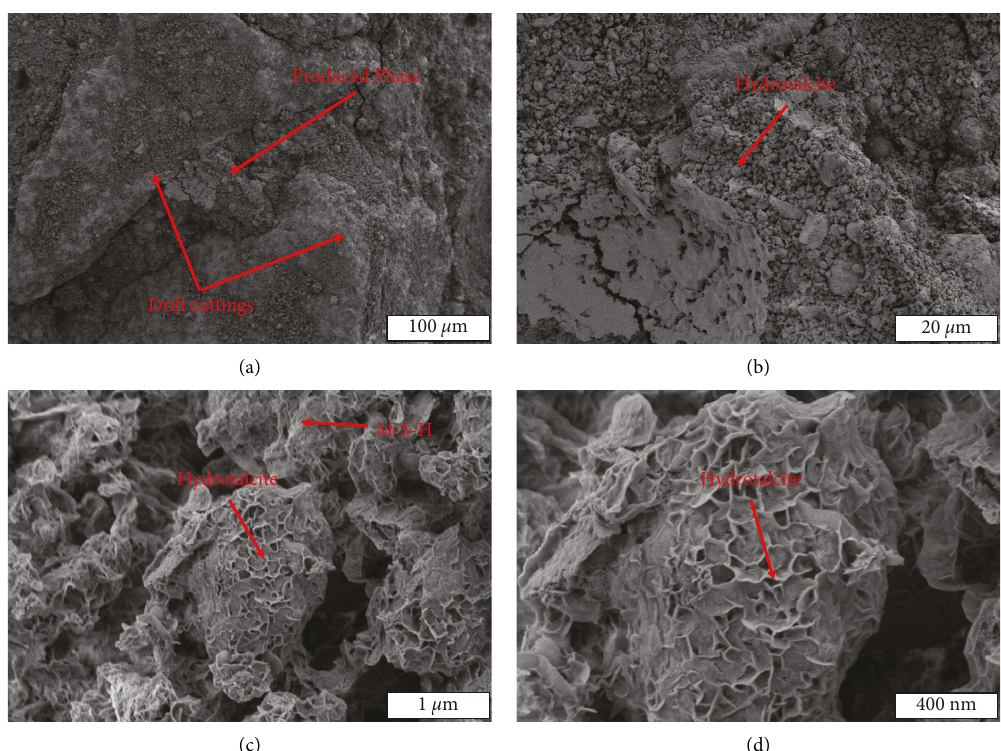
Figure 7: SEM images of the RMC-based WDC samples after 28 days of